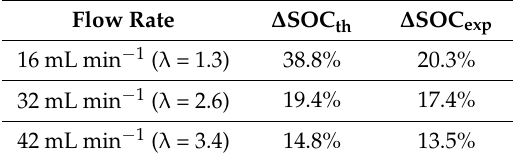
Table 3. Theoretical and experimental ∆ SOC conversion for the contour shown in Figure